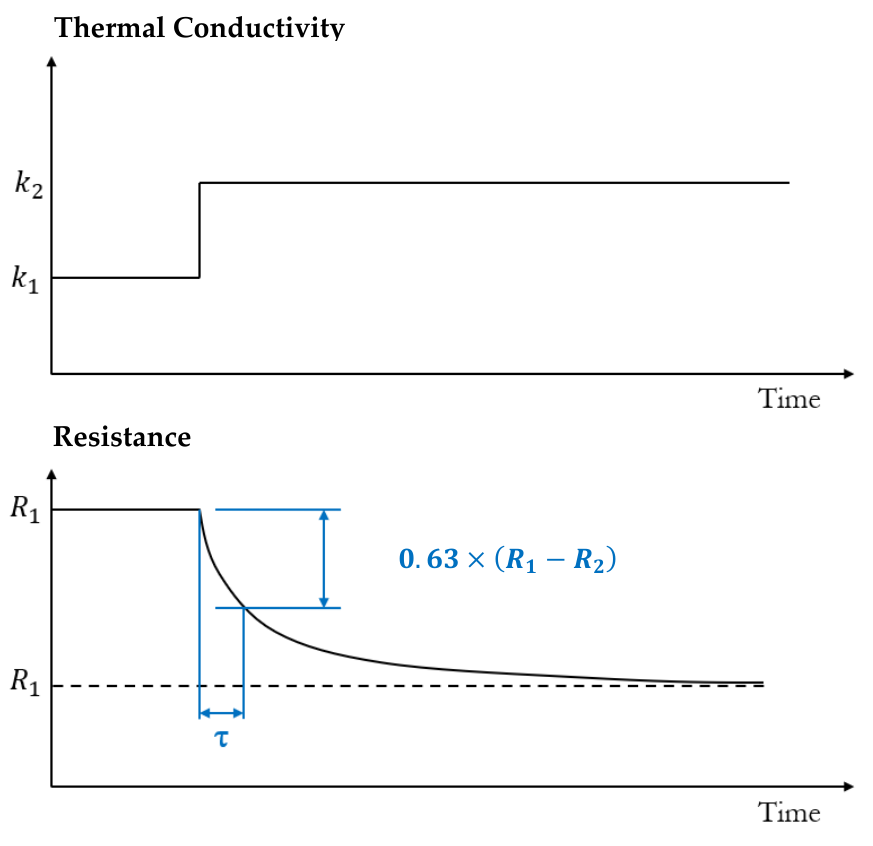
Figure 7. Transient response of the resistance of a constant current hot wire to a change in fluid thermal conductivity.